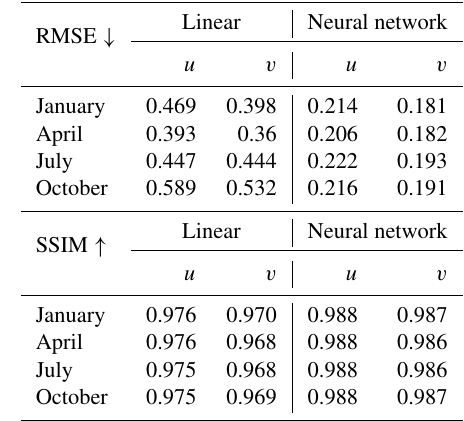
Table 1. RMSE and mean SSIM of the validation data set for lin- ear and neural network interpolation using model2 . Considering the RMSE, the neural network interpolation is at least 49% more accurate compared to the linear interpolation.